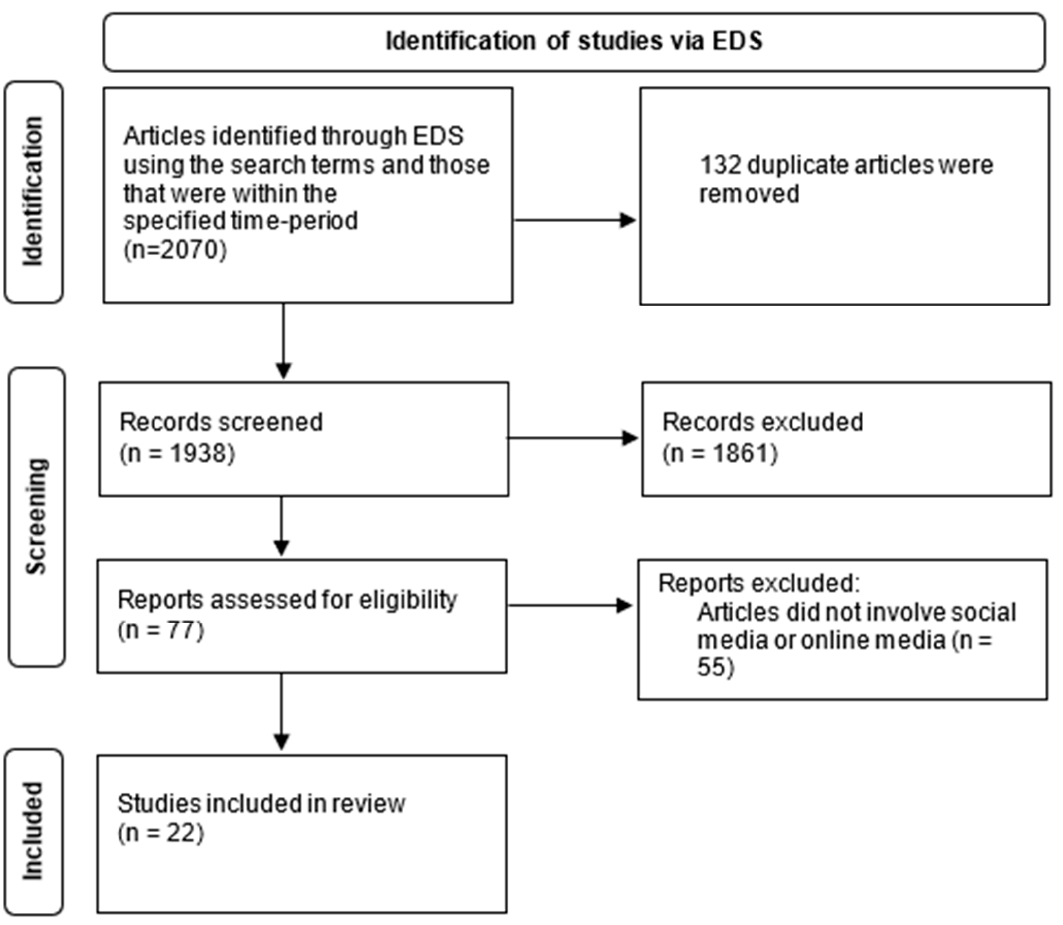
Figure 1. Literature search process (adapted from Page, et al. [14] ).